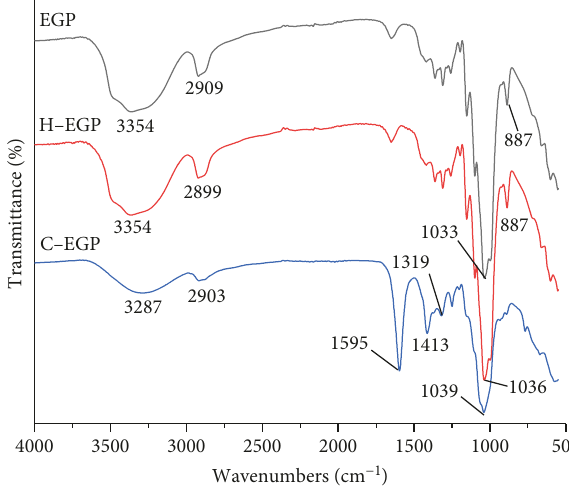
Figure 1: FTIR spectra of EGP and its